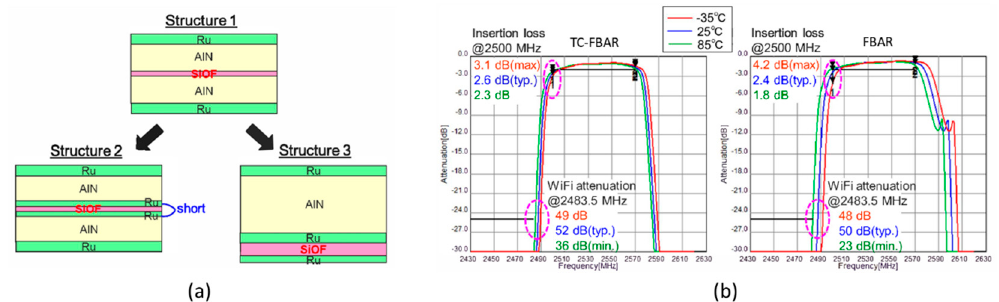
Figure 15. ( a ) Structure of the TC-FBAR with SiOF layer [99]. ( b ) Passband performance of TC-FBAR of structure 3 and conventional FBAR [99]. Reproduced with permission from [99].